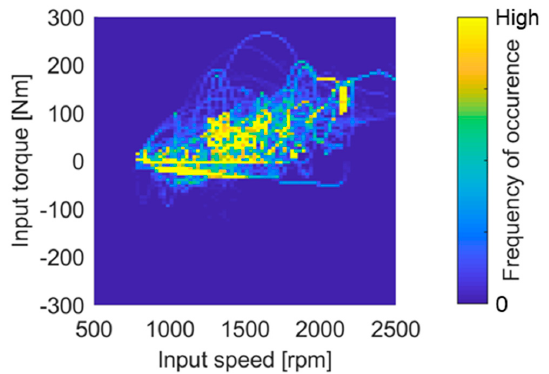
Figure 8. Load spectrum of the transmission input torque for the conventional drivetrain in the WLTC.